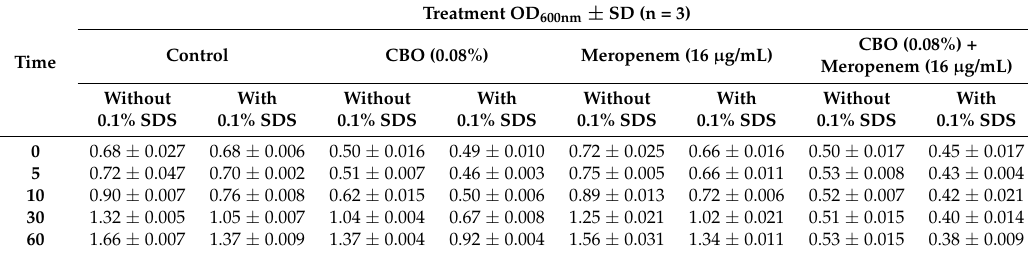
Table A4. Raw data of outer membrane permeability